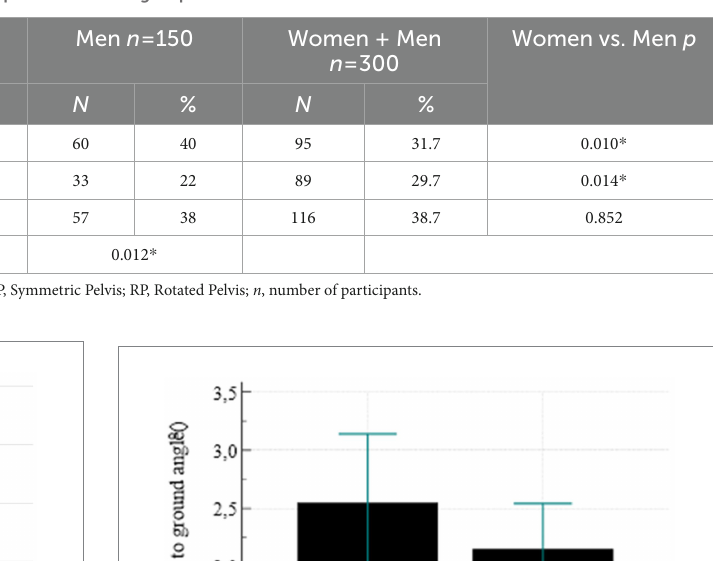
TABLE 4 Frequency of occurrence of pelvic girdle asymmetry types in examined groups.